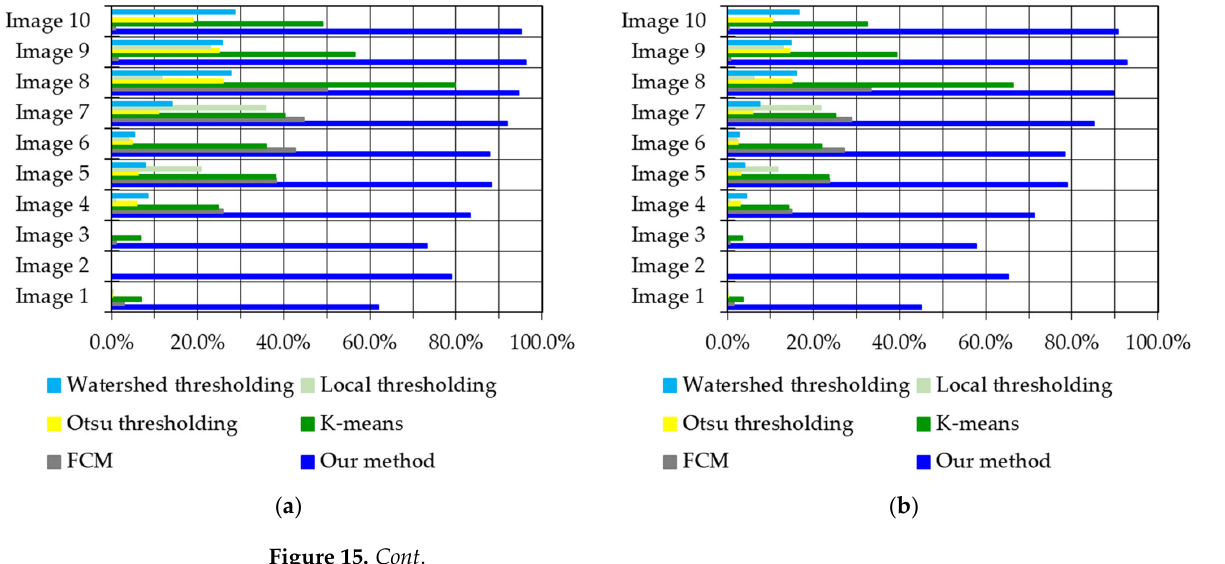
Table 8. Comparison between the results of our segmentation method on the KICA dataset and some well ‐ known segmentation techniques using the RMSE metric.